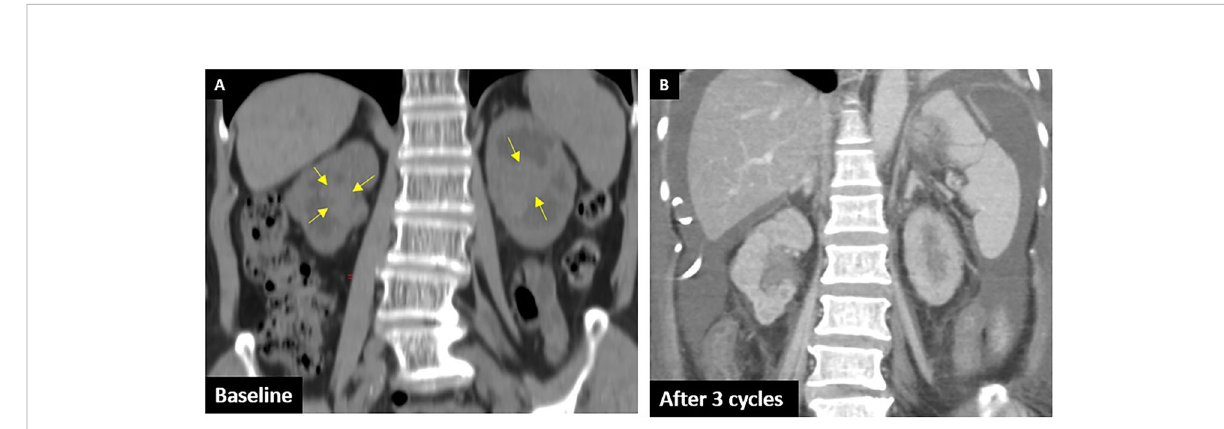
FIGURE 2 CTU of case 2. (A) Baseline: arrows show the UC in the bilateral renal pelvis with parenchyma invasion. (B) After three cycles: shows remission of bilateral tumors.